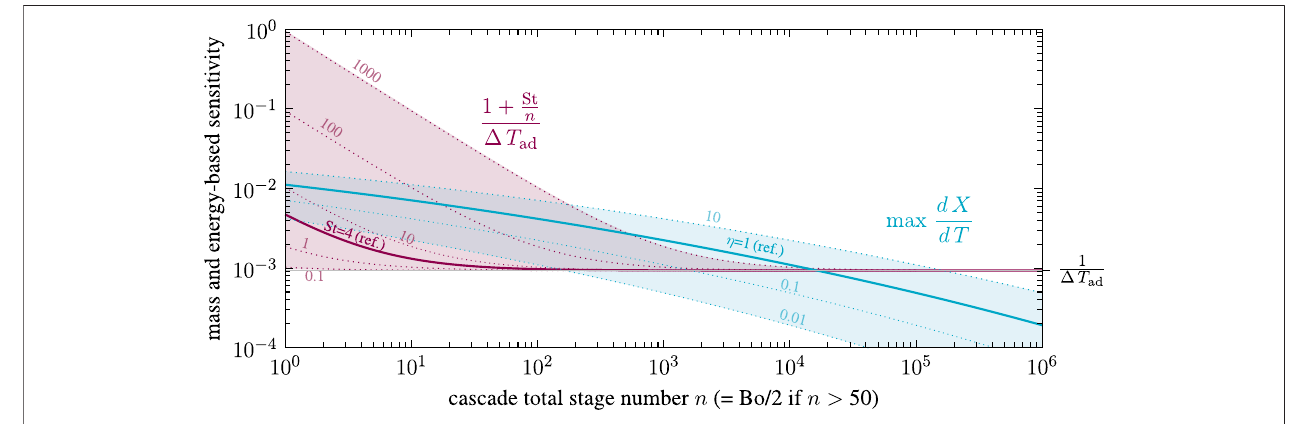
FIGURE 13 | First stage mass and energy-based sensitivity for non-isothermal CSTR cascades with various stage number, effectiveness factor and Stanton number, reference setting taken from Supplementary Table S1 .